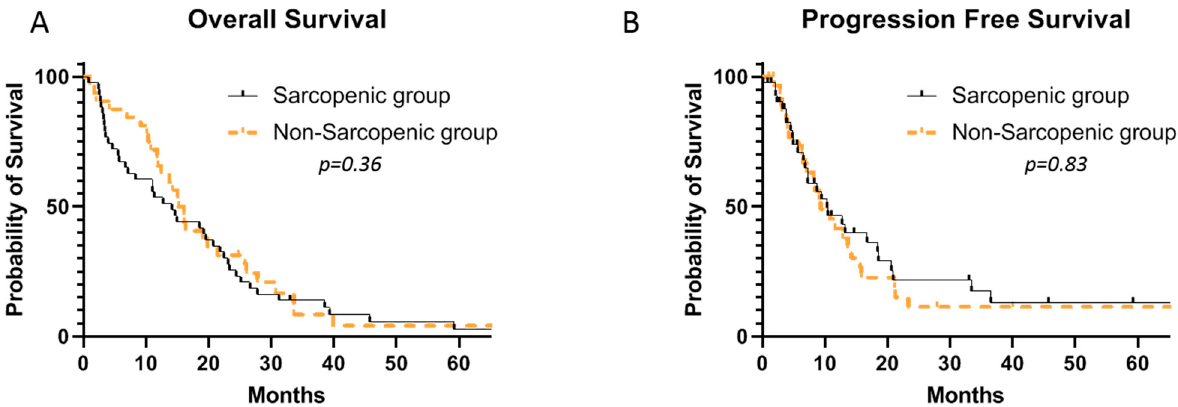
Figure 3. Median OS ( A ) and PFS ( B ) in sarcopenic and non-sarcopenic patients receiving FOLFIRINOX for metastatic pancreatic carcinoma.